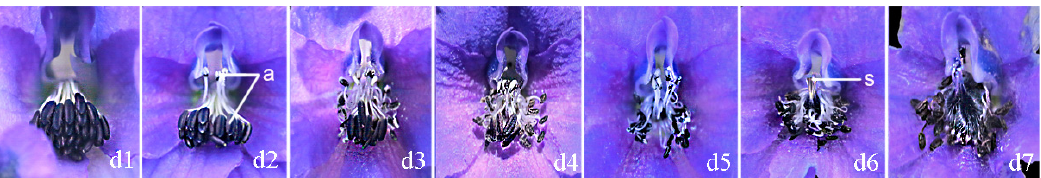
Figure 3. The flowering period of a single flower of D. caeruleum (a—anthers, s—stigmas). male phase of 1–5 d, female phase of 6–7 d.